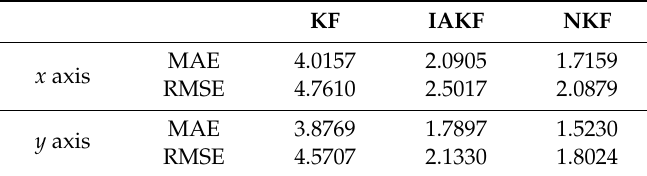
Table 3. Evaluation of filtering errors (segment of the trajectory).